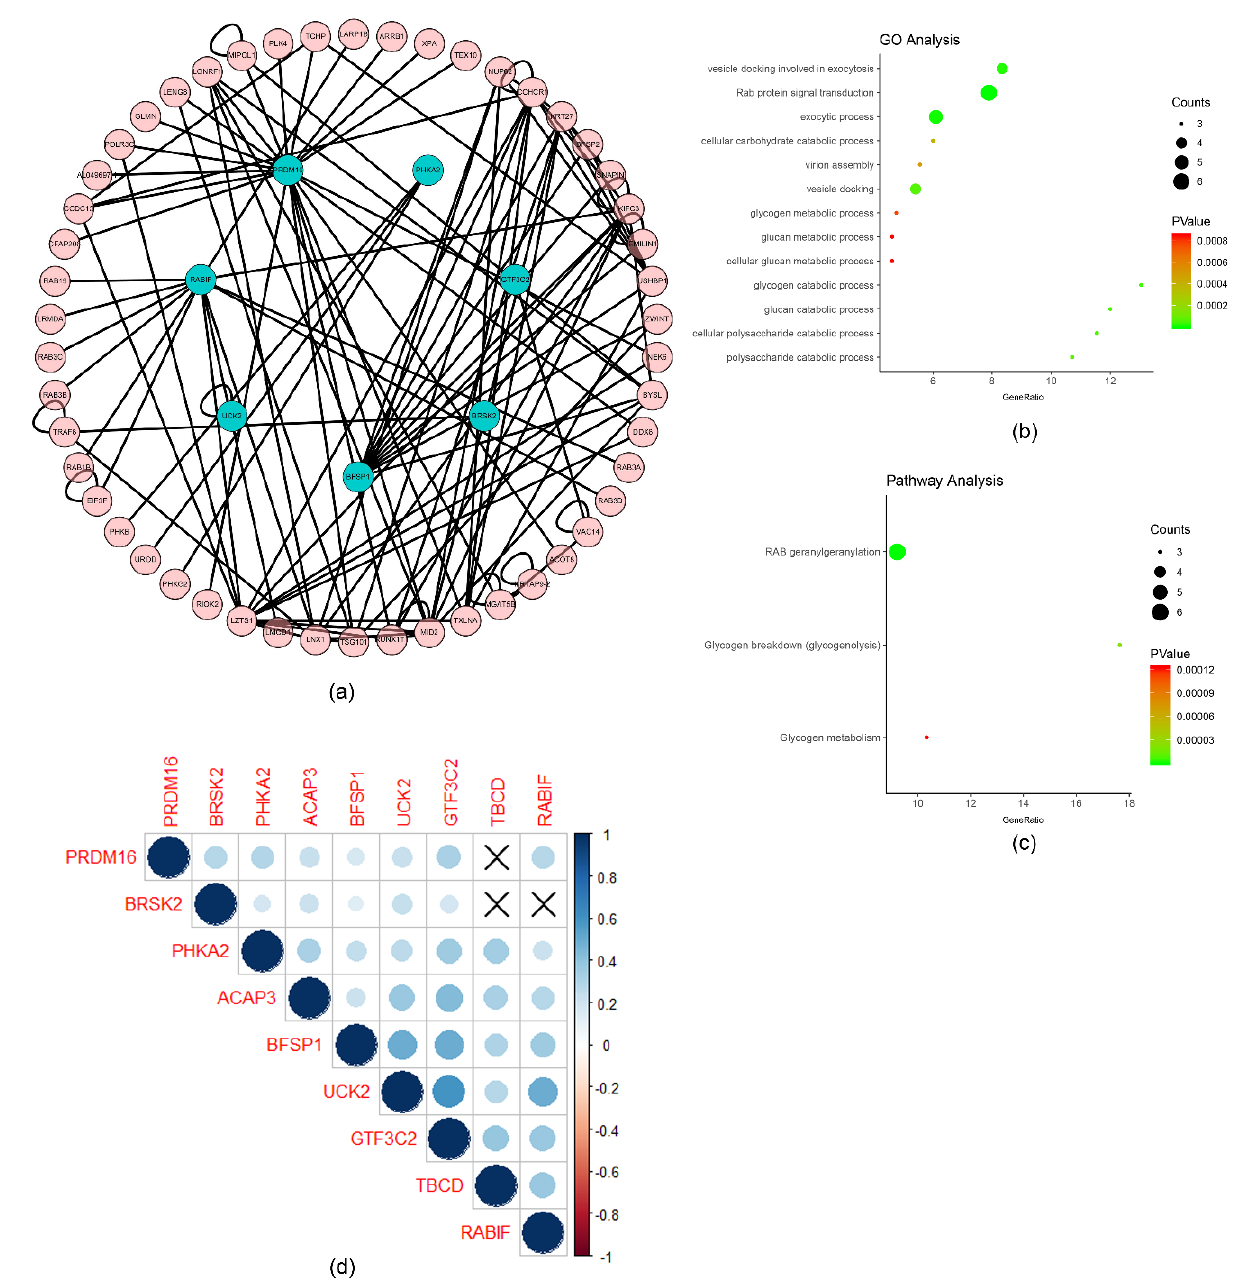
Figure 6. Interactions, functions, and correlations of 9 survival-related m6A RNA methylation-related genes. ( a ) The protein–protein interaction network of 9 m6A RNA methylation-related genes with interacting proteins. ( b ) GO analysis of proteins in ( a ). ( c ) Pathway analysis of proteins in ( a ). ( d ) Spearman correlation analysis of 9 survival-related m6A RNA methylation-related genes.